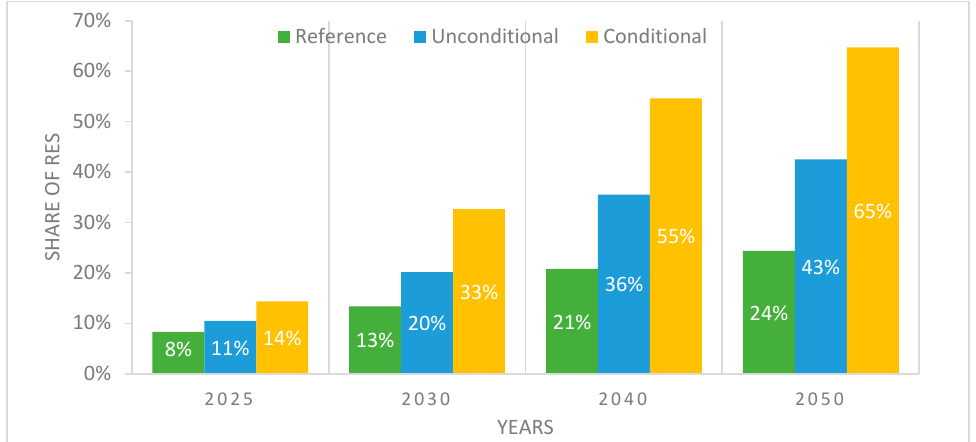
Figure 7. Share of RES (%) in electricity generation across different scenarios over 2025–2050. Source: MENA-EDS Model (Reference, Unconditional and Conditional NDC Scenarios).